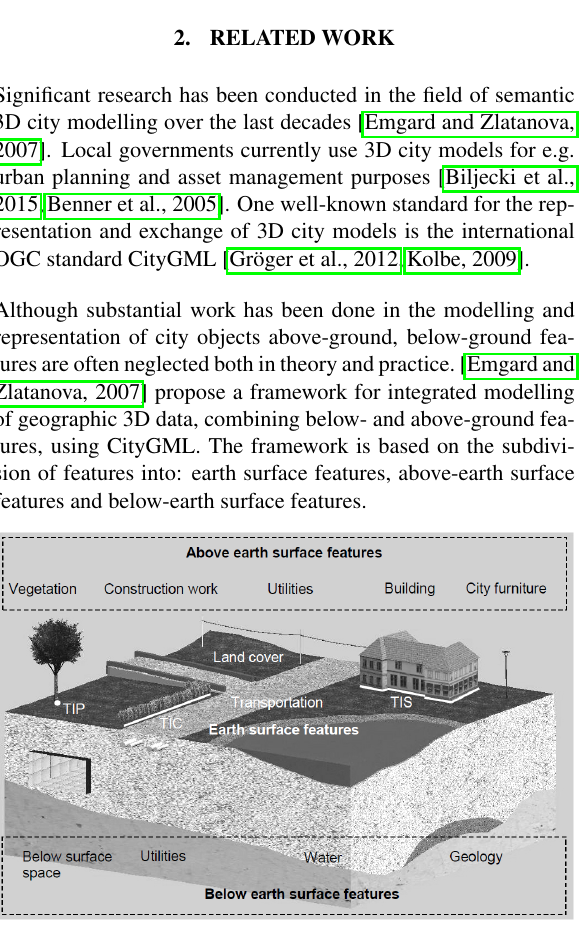
Figure 1. Subdivision of features with respect to their position above or below ground (according to [Emgard and Zlatanova,